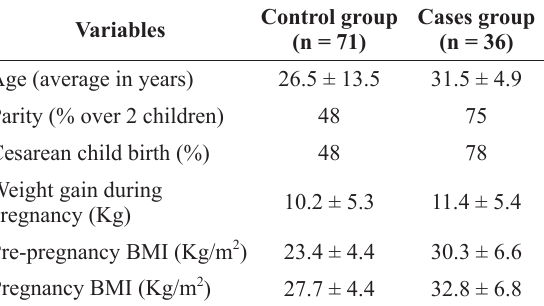
Maternal and childbirth characteristics of the population